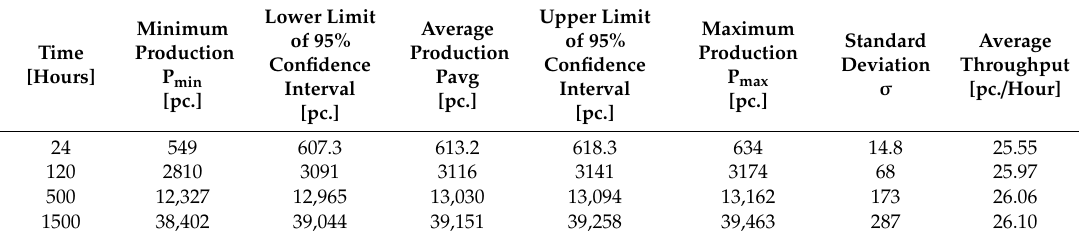
Table 3. The results of simulation experiments (Average production completed Pavg, in [pieces] for 6 AGVs with battery charging, with AGVs failures, MTBF = 500 h, MTTR = 8 h, 30 simulation runs in each experiment, 95% confidence